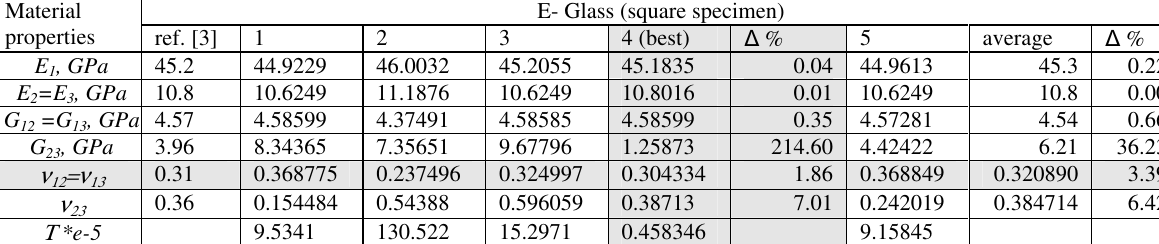
E- Glass (square specimen) Material